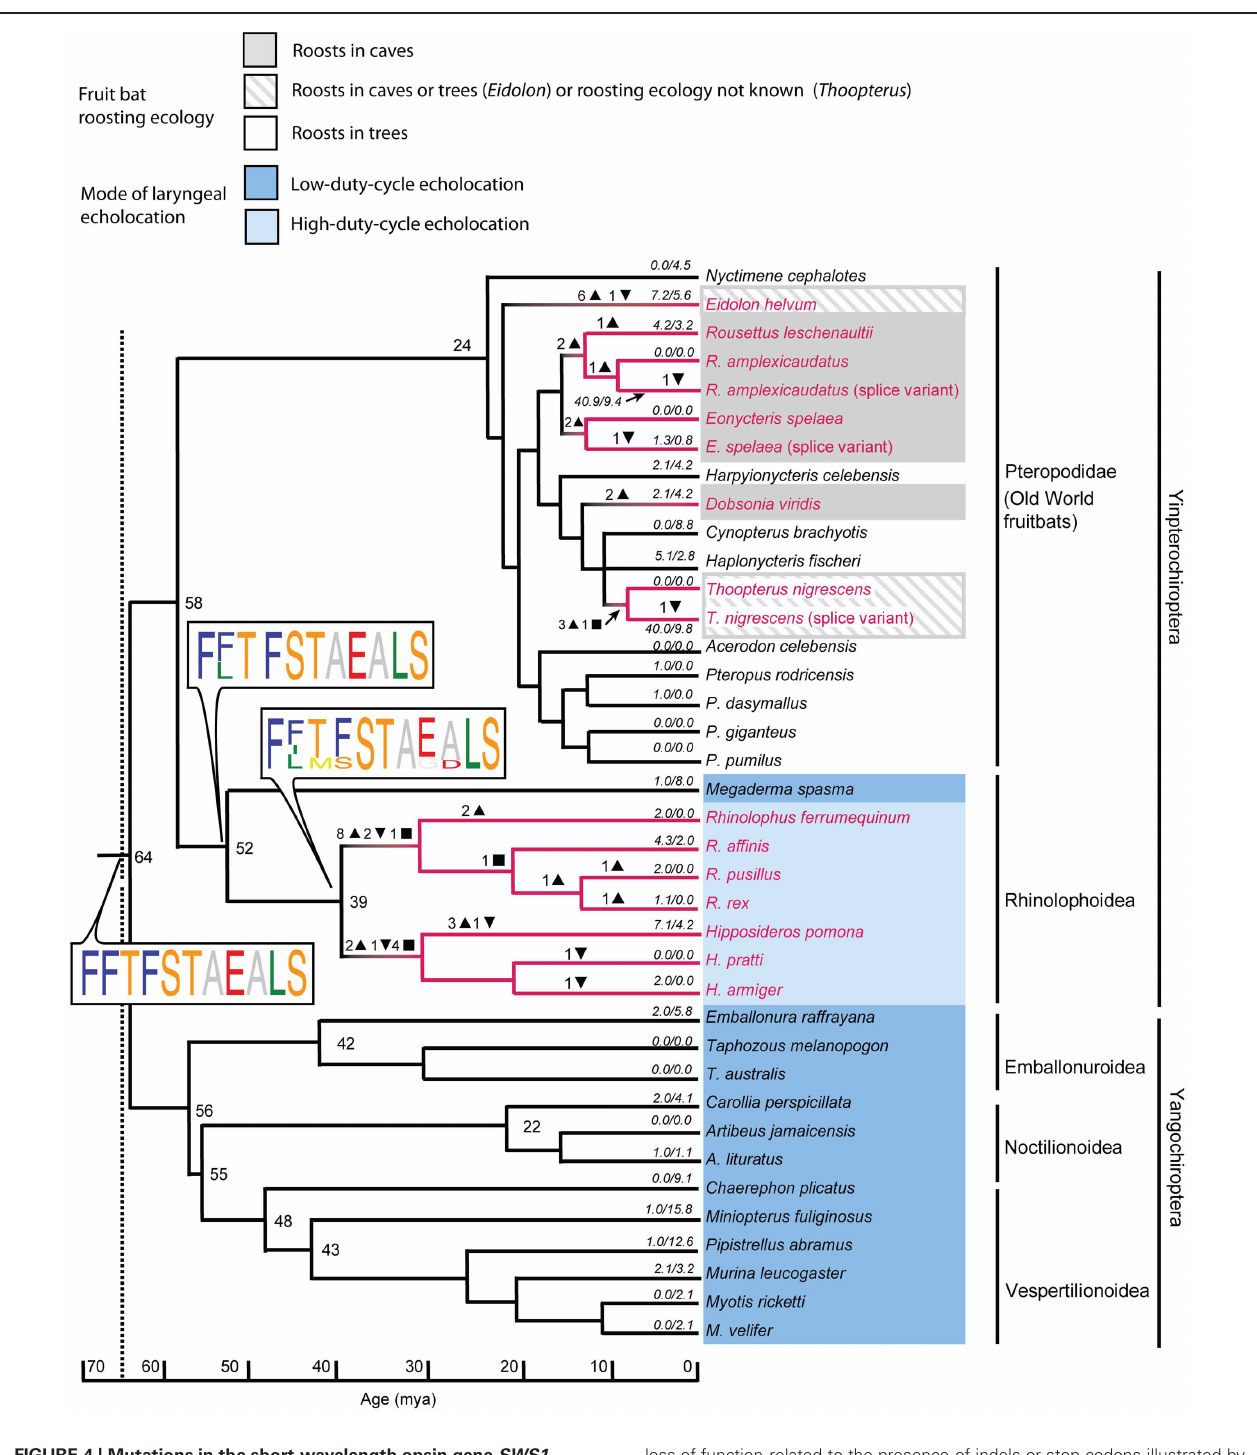
FIGURE 4 | Mutations in the short-wavelength opsin gene SWS1 mapped onto the species tree based on published dated phylogenies of bats. The tree shows substitution rates, indels, and stop codons. Numbers of insertions and deletions are illustrated by downward and upward triangles respectively. Inferred ancestral stop codons are shown by squares. Sequence logos show key changes in spectral tuning amino acid sites in which the height of the amino acid abbreviation is proportional to its posterior probability. Sequences with stop codons are shown in red font, with